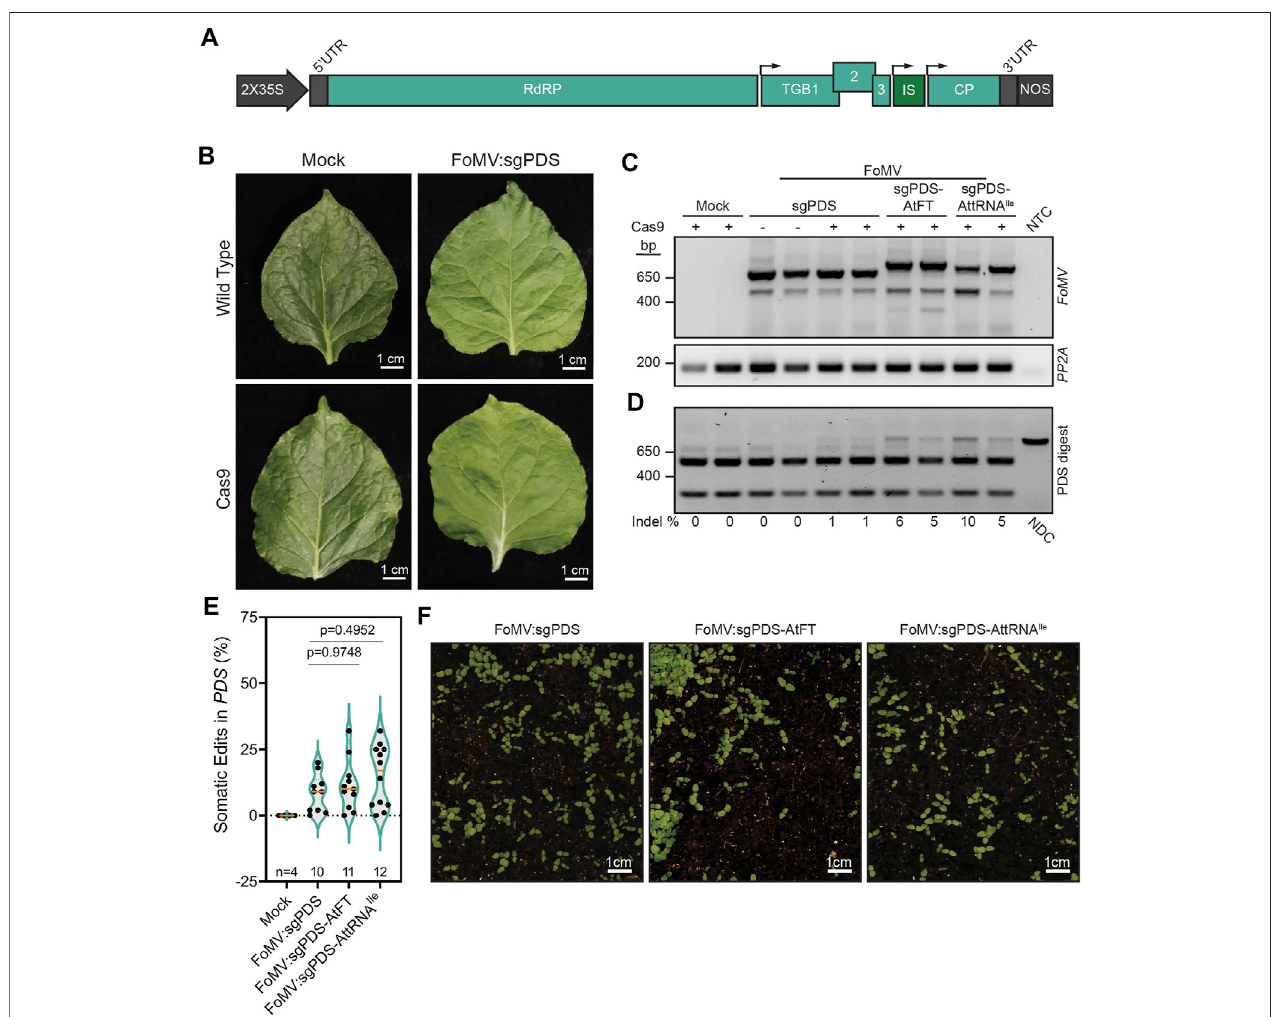
FIGURE1 | Effects ofRNAmobilitysignals on FoMV-induced gene editing of NbPDS in Nicotiana benthamiana . (A) Schematic representation ofthefoxtail mosaic virus(FoMV)vector.TheFoMVgenomeistranscribedunderthecontrolofa2Xcauli fl owermosaicvirus35Spromoter(35S)andthenopalinesynthase(NOS)terminator. The FoMV genome consists of an RNA-dependent RNA polymerase (RdRP), triple gene block proteins (TGB1, 2, 3), and coat protein (CP), fl anked by 5 ′ and 3 ′ untranslated regions (UTRs). sgRNAs or sgRNAs fused to RNA mobility signals are located in the insertion site (IS) between TGB3 and CP. Small black arrows above the FoMV genome represent the positions of the subgenomic promoters. (B) Images of systemic leaves of wild type or Cas9 N. benthamiana plants that were eithermock-inoculatedorinoculatedwithFoMV:sgNbPDS(PDS)5 weekspost-inoculation. (C) RT-PCRampli fi cationofFoMVinsystemicleaf8,approximately5 weeks after inoculation. Primers fl anking the IS of FoMV were used to demonstrate the stability of sgRNAs and sgRNAs fused to AtFT or AttRNA Ile . Intact FoMV:sgRNA is represented by a 571 bp amplicon, FoMV:sgRNA-AtFT is represented by a 673 bp amplicon, and FoMV:sgRNA-AttRNAIle is represented by a 646 bp amplicon. A 475 bpampliconrepresentsFoMVinwhichthesgRNAandmobilitysignalinsertisfullydeleted,ampliconsbetween475 bpandtheapplicableintactampliconbandsize represent partial deletions of the insert. RT-PCR ampli fi cation of N. benthamiana PP2A (PP2A) serves as an internal control, and NTC is the no template control. Mock- inoculated Cas9 N. benthamiana serve as a negative control for FoMV infection, and FoMV:sgPDS infected wild type N. benthamiana serve as a negative control for somatic mutations. (D) A representative gel showing FoMV-induced somatic mutations (see Supplementary Figure S2 for additional gels). A fragment of the NbPDS gene containing the sgNbPDS target site was PCR ampli fi ed from genomic DNA isolated from systemic leaf tissue of wild type or Cas9-expressing transgenic N. benthamiana infected with FoMV containing sgNbPDS or sgNbPDS fused to AtFT or AttRNA Ile . The resulting amplicons were digested with Nco I restriction endonuclease to test for the presence of indels disrupting the restriction site. The non-digested control (NDC) represents the wild type 797 bp NbPDS amplicon and undigested amplicons containing indels. The absence of indels at the Nco I site results in fragments resolving at 256 and 541 bp. The percentage of somatic mutations detectable for each represented plant is noted underneath the gel image, ratios were calculated from digested and non-digested fragment intensities obtained using ImageJ. Mock-inoculated transgenic Cas9 N. benthamiana serve as a negative control for FoMV infection, and FoMV:sgPDS infected wild type N. benthamiana served as a negative control for somatic mutations. (E) A summary of all NbPDS amplicons containing indels induced by FoMV:sgNbPDS, FoMV:sgNbPDS-AtFT, and FoMV: sgNbPDS-AttRNAIle are reported as percentages in a violin plot, ratios are calculated from fragment intensities using ImageJ, data points are reported from two replicates with n representing the number of plants. The median and fi rst and fourth quartiles for each data set are represented by a solid orange line and dotted green lines, respectively. Pairwise p -values are indicated from statistical analysis by one-way ANOVA and subsequent post hoc Student ’ s t-test for each comparison. (F) Representative images of progeny from parental N. benthamiana plants infected with FoMV containing sgNbPDS, sgNbPDS-AtFT, or sgNbPDS-AttRNAIle. Two independent replicates of this experiment were conducted.